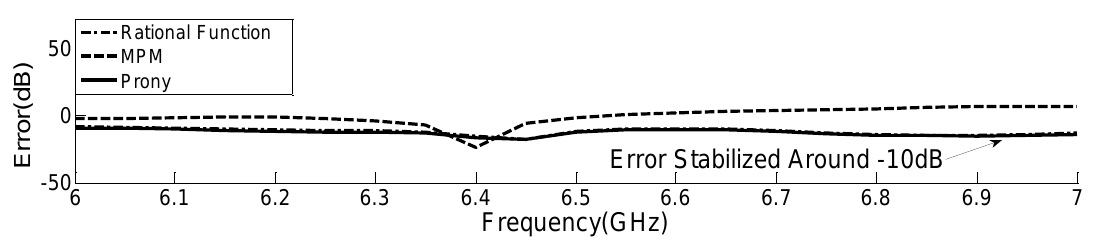
Figure 6. Transport Plane RCS prediction errors at 18 deg.